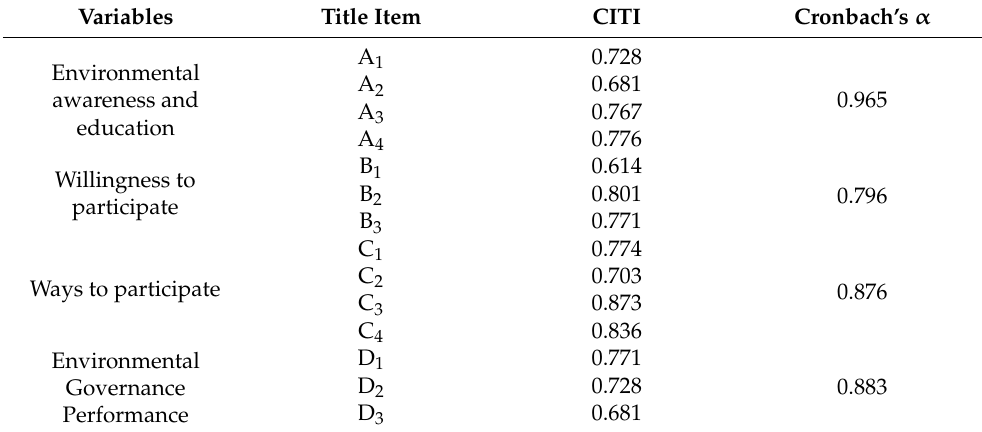
Table 2. Results of the reliability test of the